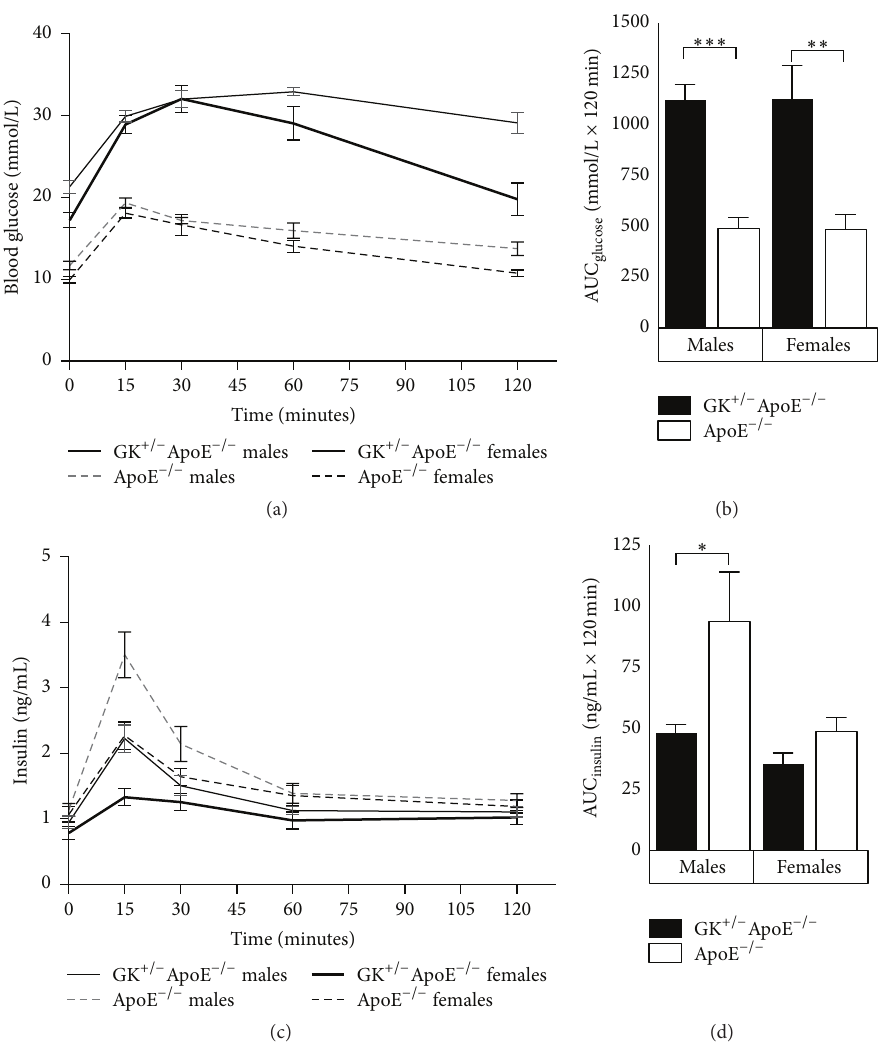
Figure 4: Oral Glucose tolerance test ((a) and (b)) and insulin ((c) and (d)) in the GK +/− ApoE −/− mice compared with the ApoE −/− mice after 14 weeks on Western diet. Both male and female GK +/− ApoE −/− mice display significantly impaired glucose-stimulated insulin secretion. Values are presented as means and standard error of mean (SEM). ∗ 𝑝 < 0.05 , ∗∗ 𝑝 < 0.005 , and ∗∗∗ 𝑝 < 0.0001